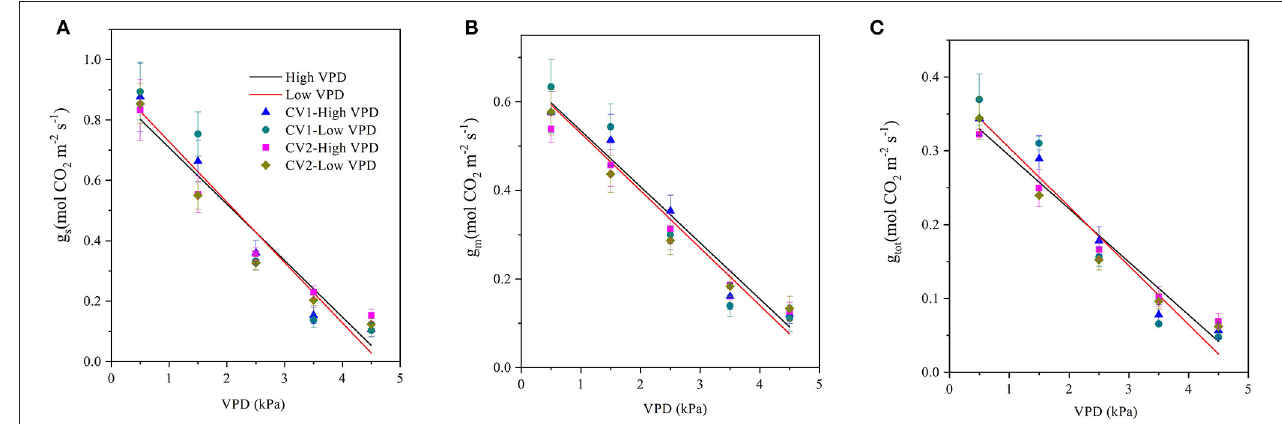
FIGURE 2 | Effect of the VPD on the stomatal conductance (g s ), mesophyll conductance (g m ), and total conductance (g tot ) for photosynthetic carbon dioxide (CO 2 ) diffusion. Values are the mean ± SE ( n = 4 replicates). The regression lines shown are: (A) HVPD, g s = − 0.187 VPD + 0.895, R 2 = 0.94; LVPD, g s = − 0.200 VPD + 0.928, R 2 = 0.92. (B) HVPD, g m = − 0.126 VPD + 0.661, R 2 = 0.95; LVPD, g m = − 0.129 VPD + v0.658, R 2 = 0.94. (C) HVPD, g tot = − 0.0719 VPD + 0.365, R 2 = 0.95; LVPD, g